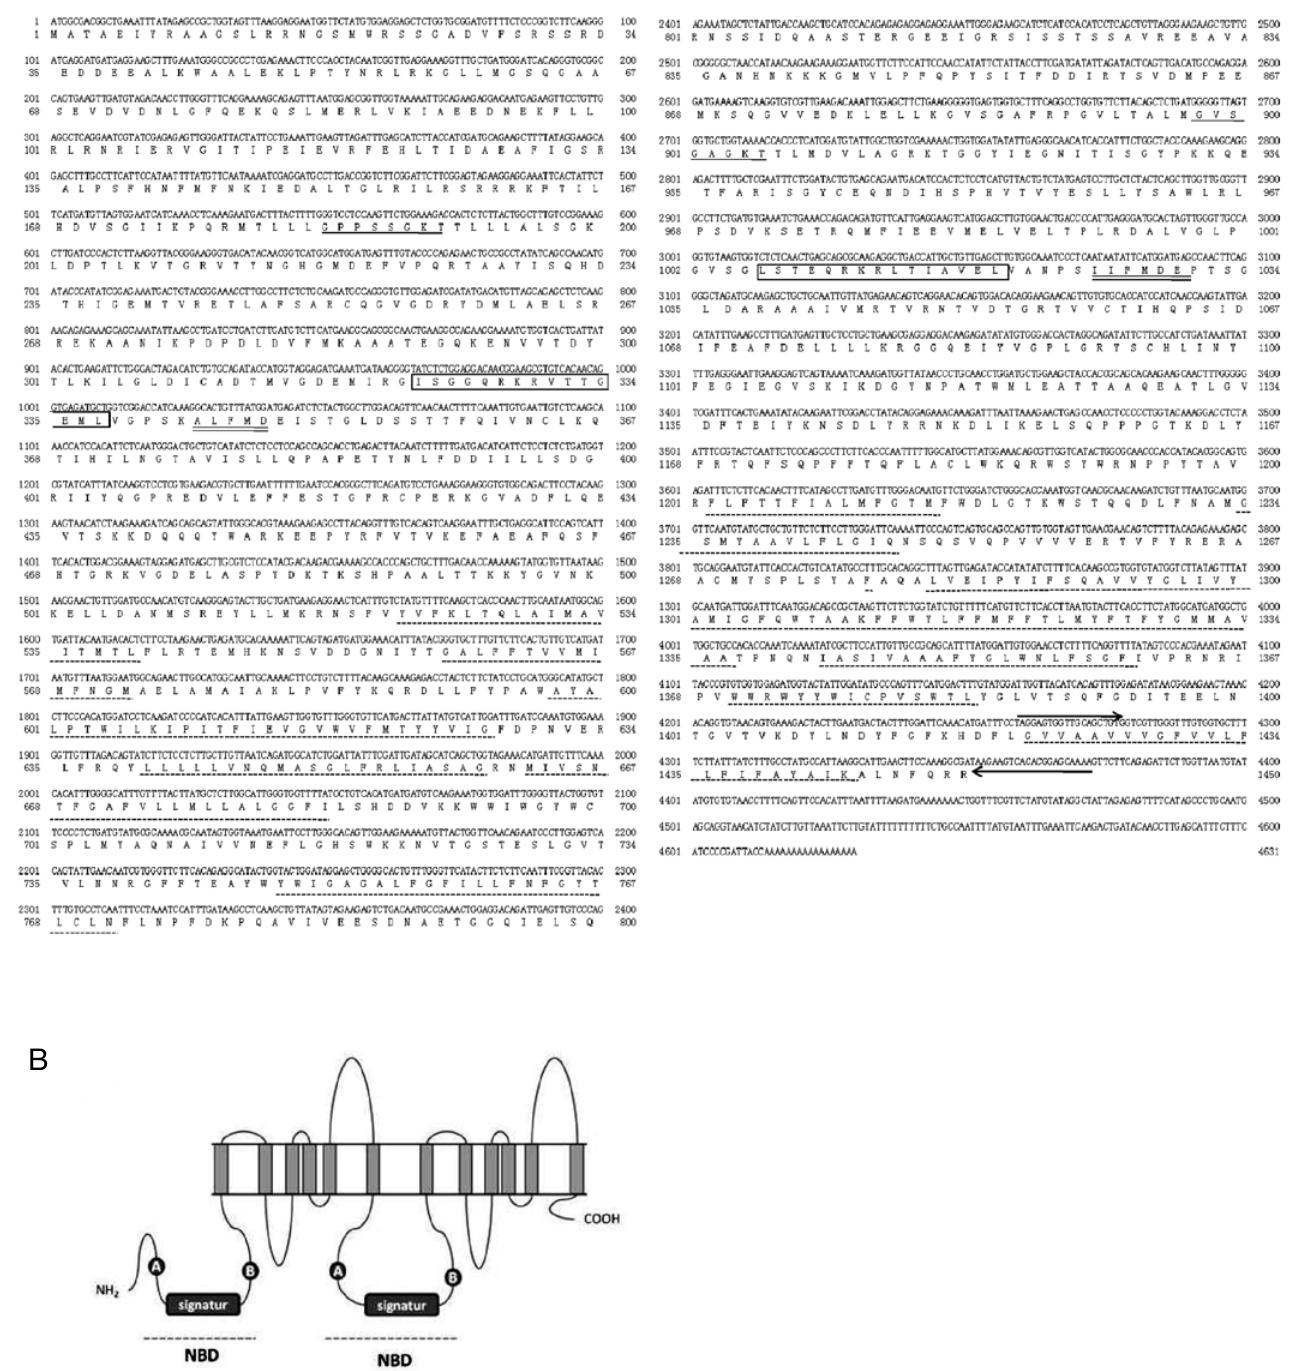
Fig. 1 - Nucleotide sequence, amino acid sequence, and topology of VvABCG44 A: Nucleotide sequence of VvABCG44 and the deduced amino acid sequence. Walker A motifs are underlined. ABC signature motifs are boxed. Walker B motifs are double underlined. Transmembrane domains are dotted-lined. Arrows indicate the primers for quantitative PCR analysis. B: Putative topology of VvABCG44. The protein is composed of two halves and each half harbors TMD (gray boxes) and NBD (dashed lines), which contains an ABC signature and Walker A and B motifs.